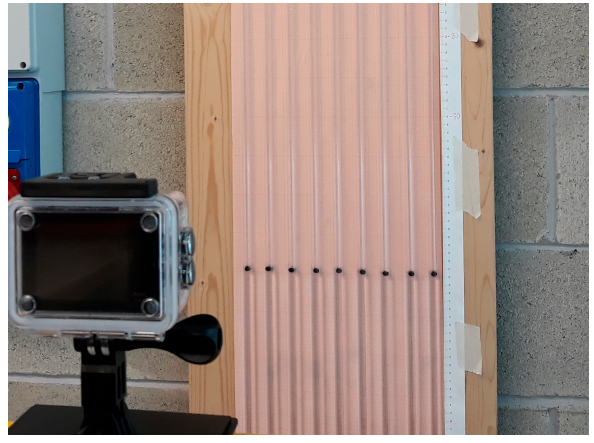
Figure 1. Camera shooting the piezometer panel.